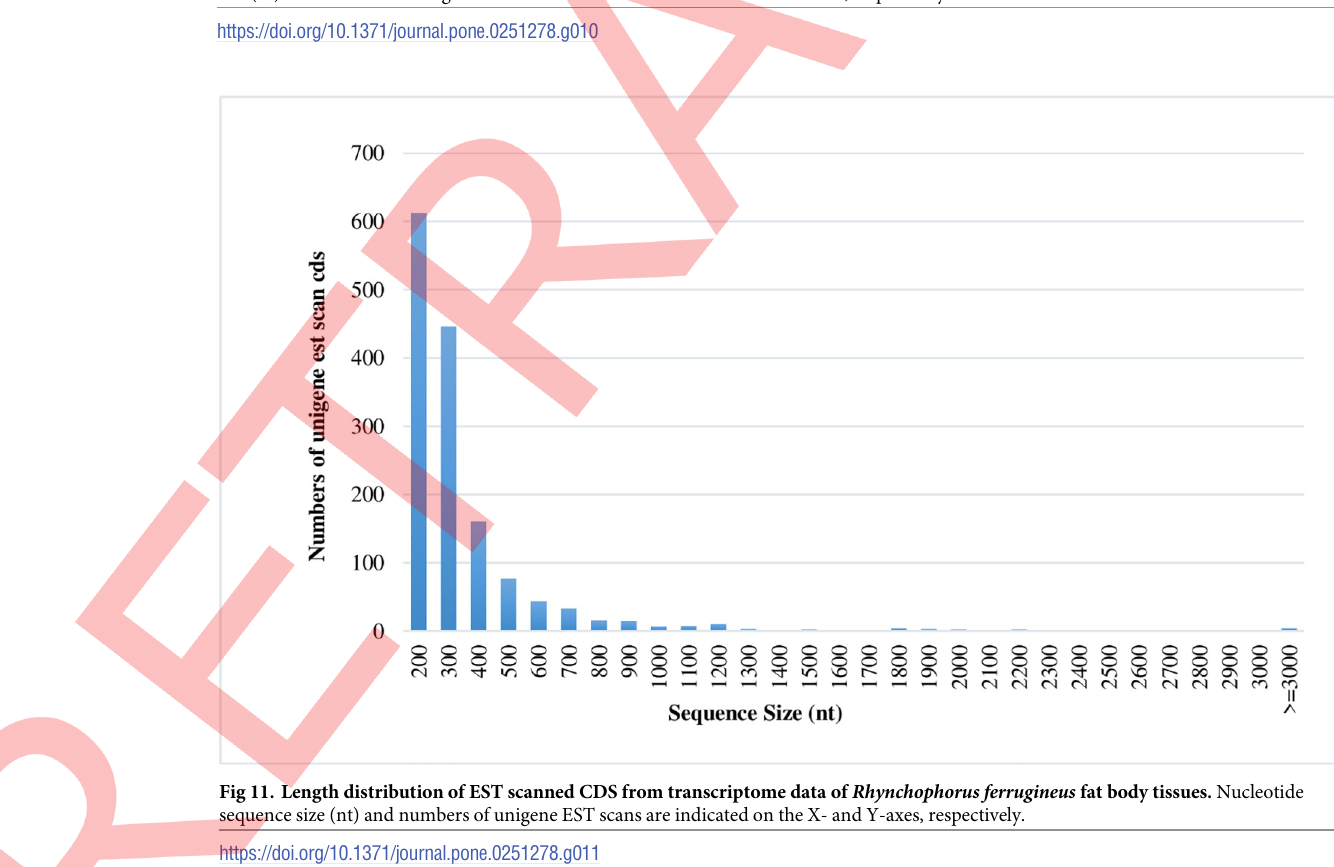
PLOS ONE | https://doi.org/10.1371/journal.pone.0251278 May 24,